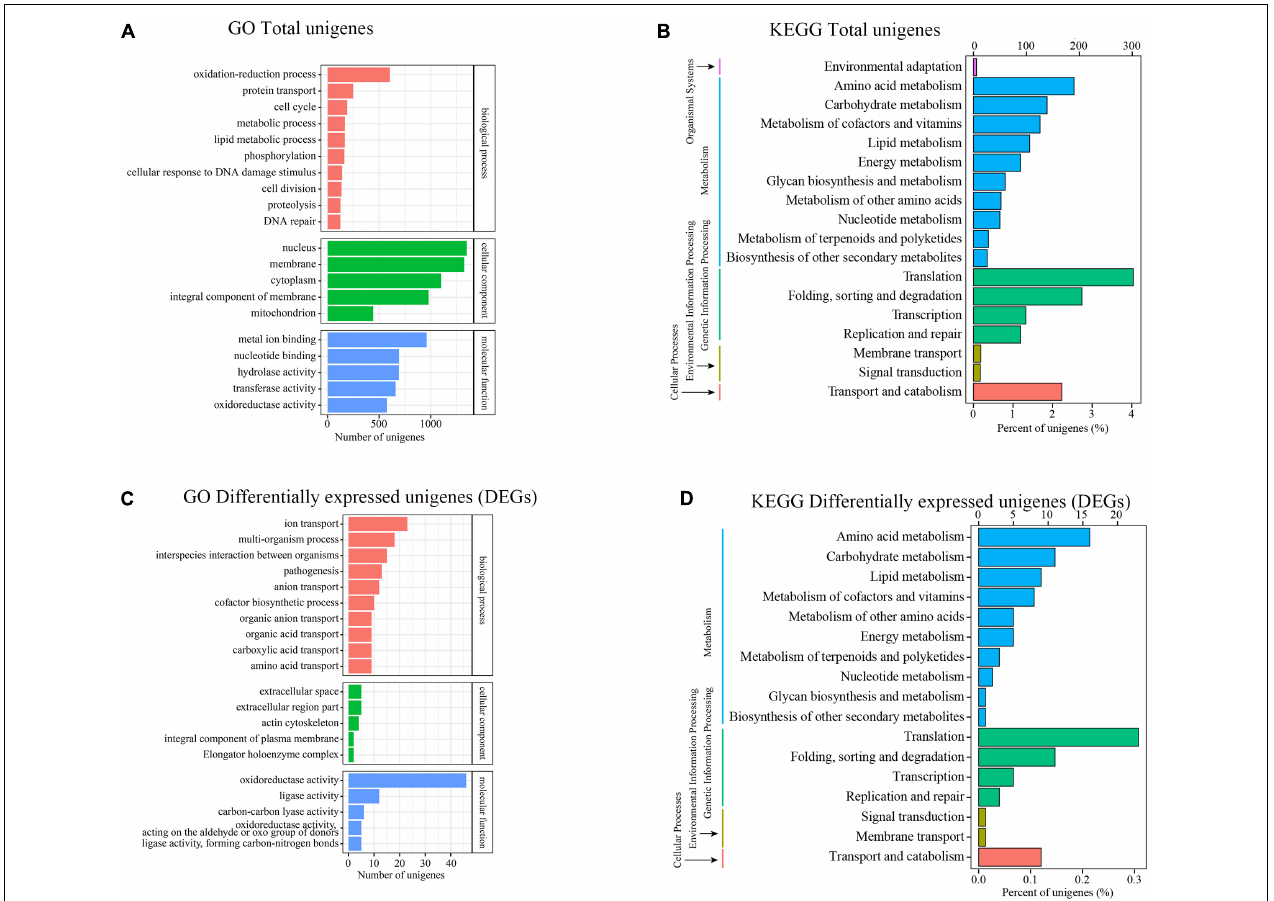
FIGURE 4 | Transcriptional analysis and DEGs differential expressions between Control and MeJA treatment groups. (A) GO enrichment analysis (Total unigenes). (B) KEGG enrichment analysis (Total unigenes). (C) GO enrichment analysis (Differentially expressesunigenes). (D) KEGG enrichment analysis (Differentially